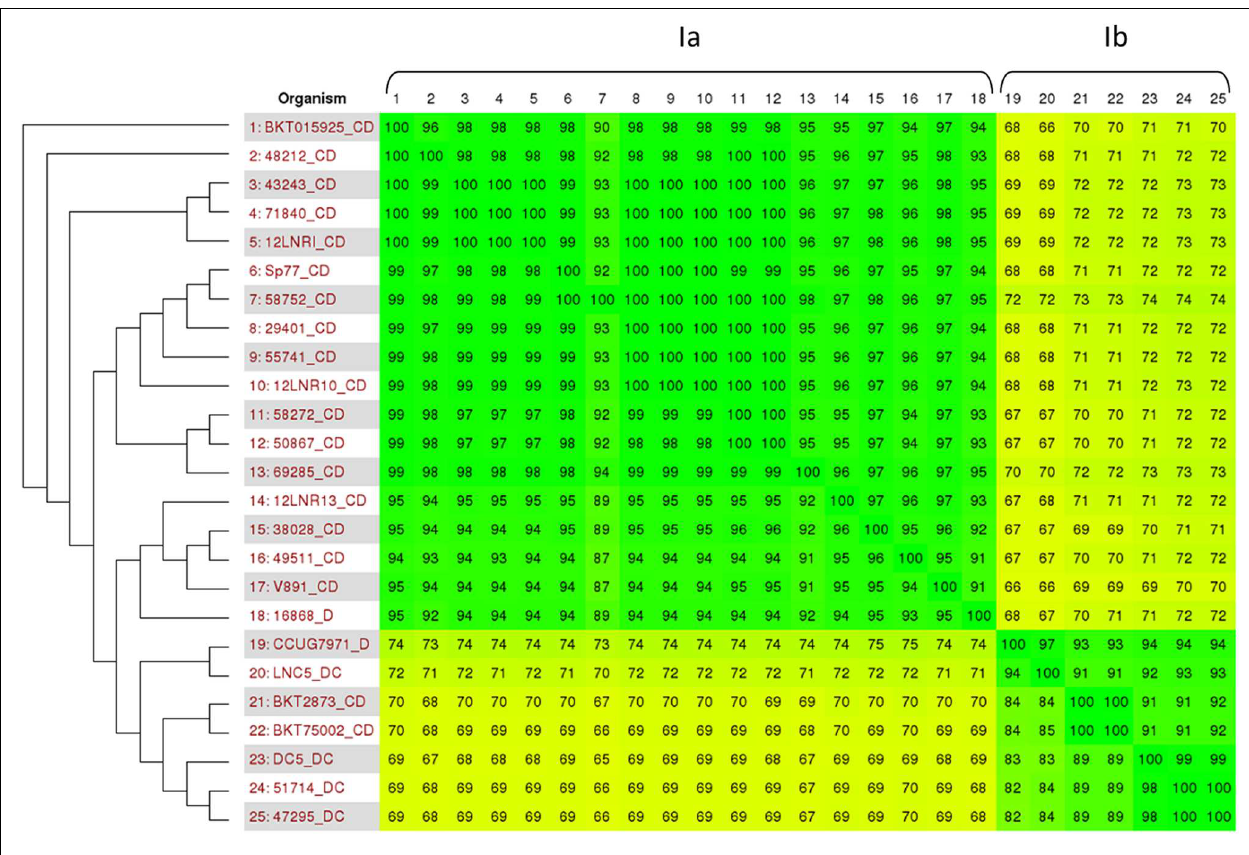
FIGURE 2 | Comparison between C. botulinum type C/D and D/C genome sequences and C. novyi sensu lato . Based on the work of Skarin and Segerman (2014) and the publicly available genome sequences, the genomes investigated were analyzed using Gegenees software. The comparison matrix obtained clearly associated our genomes with C. novyi sensu lato group Ia and Ib